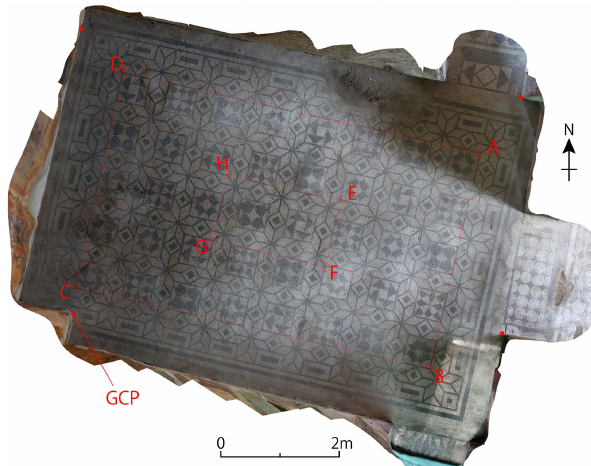
Fig.6 Orthographic image created from multiple images